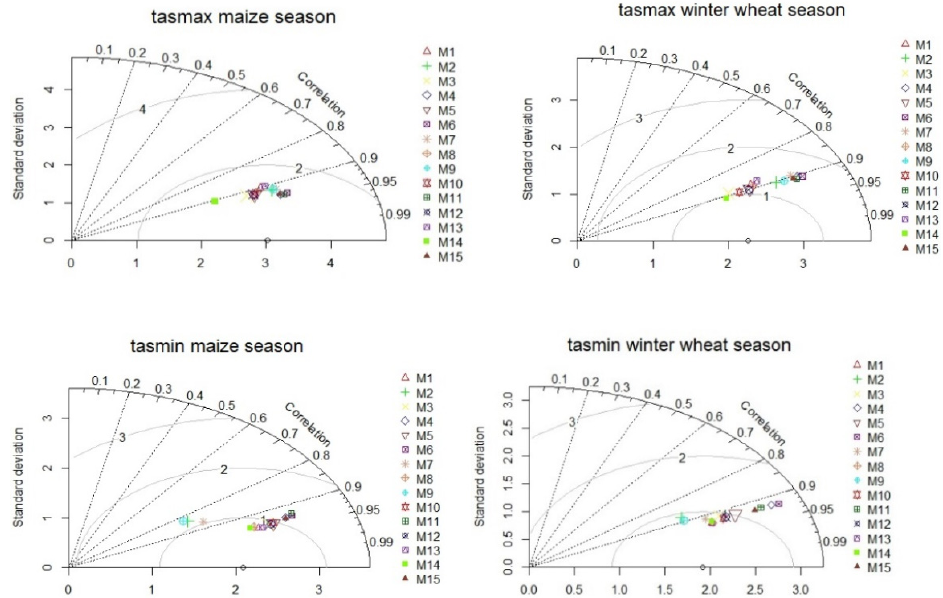
lyzed by using the Taylor diagrams. The best fit characterized the maize vegetation period case of high extremes is smaller. Some outliers are also present, namely, M8 and M9 (lower with lower RMSE and standard deviation and stronger spatial correlation (Figure 3). graphs in Figure 4).